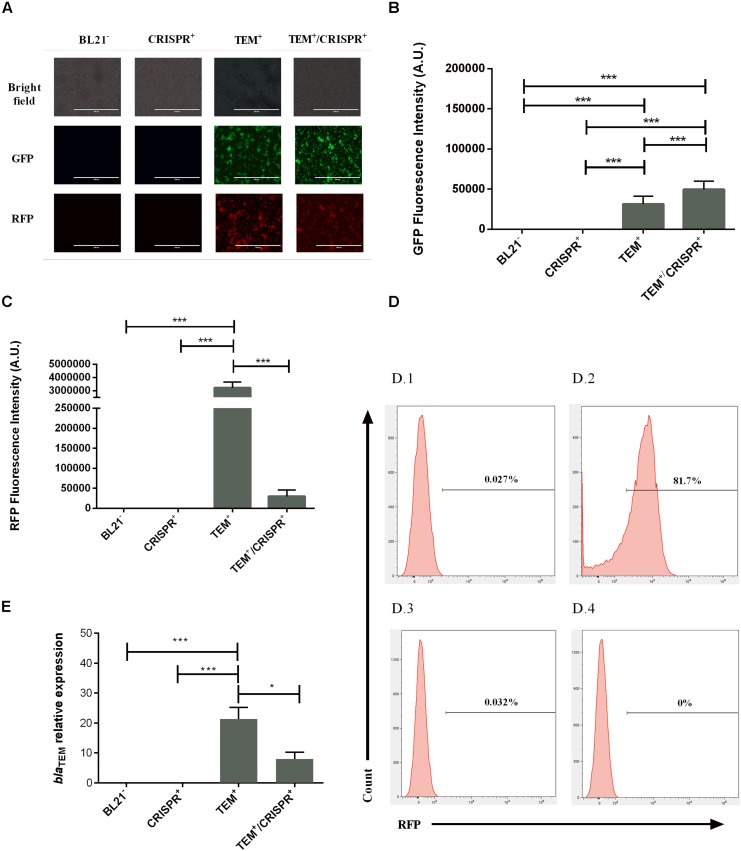
Effect of the CRISPR-Cas9 transformation on plasmid maintenance and blaTEM–1 gene expression in E. coli BL21; BL21–: BL21 strain with no plasmid, CRISPR+: strain containing the CRISPR-Cas9 system, TEM+: strain containing the blaTEM–1 resistance gene, TEM+/CRISPR+: strain containing blaTEM–1 and CRISPR-Cas9 (A) Fluorescence microscopy indicating bacterial viability and maintenance of the plasmids pSB1A2 and pSB1K3 based on the RFP/GFP signals. For each strain, pictures were taken at the same microscopy field (40× objective). (B) GFP fluorescence intensity indicating the continued presence of plasmid pSB1K3 (thus no natural causes of plasmid reduction) in strain TEM+/CRISPR+. A.U., arbitrary units. (C) RFP fluorescence intensity indicating a significant reduction of the plasmid pSB1A2 (but no entire plasmid loss) in strain TEM+/CRISPR+ compared to TEM+. Bars represent the mean of three biological and three technical replicates ± standard deviation. A.U., arbitrary units. (D) Histograms of negative (D.1) and the positive controls (D.2) of FACS analysis used to demarcate the gate areas. The plot (D.3) represents the colony with higher RFP percentage (0.032%), while (D.4) demonstrates the colony with no RFP signal (0%). When analyzing all retrieved colonies, 0.005% of RFP positive cells were present upon CRISPR-Cas9 insertion. A control experiment with the pSB1C3 vector lacking the sgRNA led to a high percentage of RFP-positive cells (85.2%), similar to TEM+ cells, confirming the sgRNA-dependant plasmid reduction. (E) Relative expression of the blaTEM–1 gene confirming plasmid presence and gene functioning in the cells. Bars represent average and standard deviation of two replicate assays. The results were normalized with the 16S rRNA housekeeping gene. *p < 0.05; ***p < 0.001.